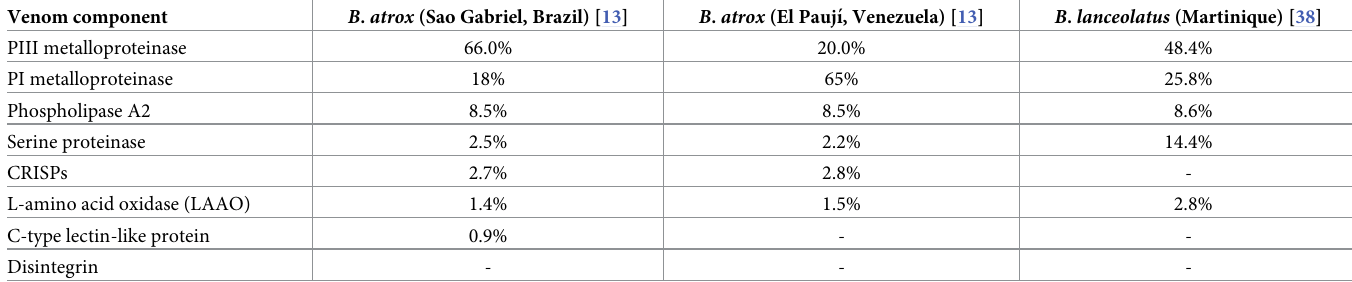
Table 2. Relative abundance of different protein families in the venom proteomes of two populations of B . atrox and B . lanceolatus (data from [13,38]). Venom component